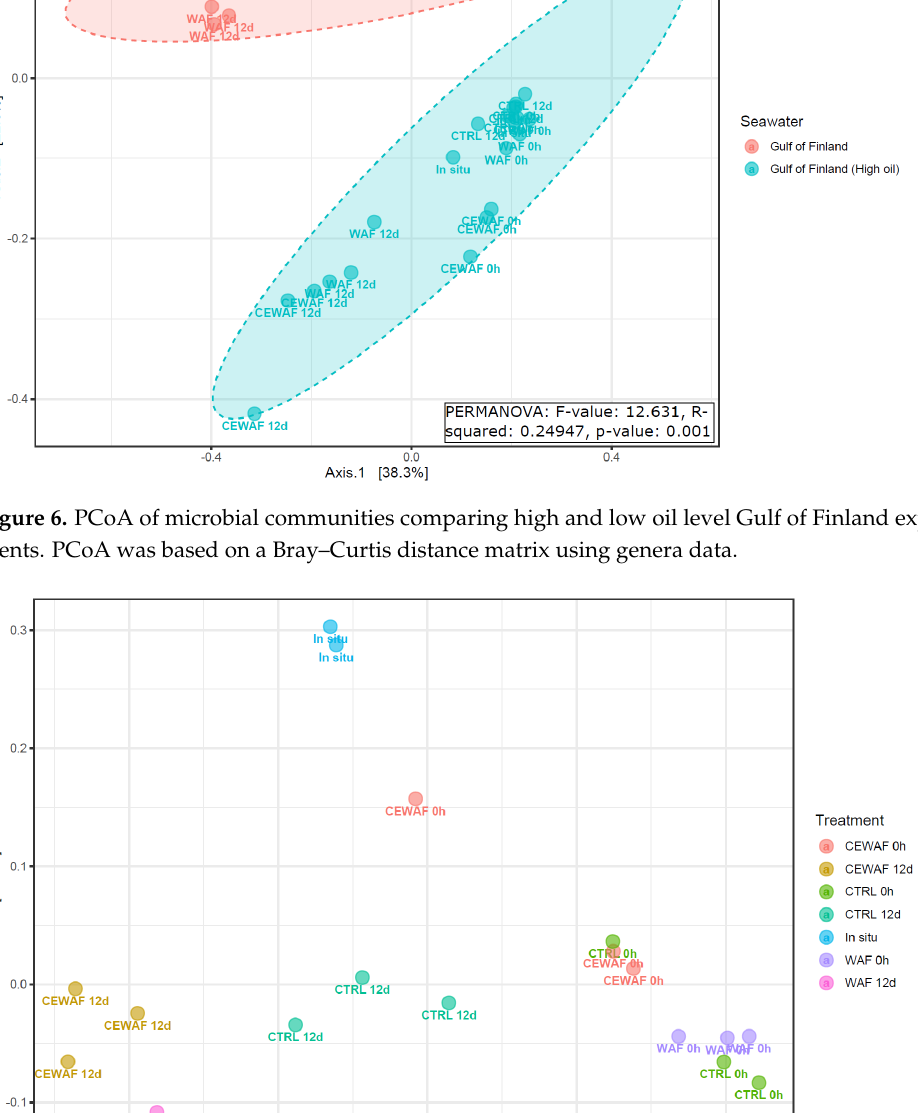
Figure 7. PCoA of microbial communities in the Norwegian Sea experiment. PCoA was based on a Bray–Curtis distance matrix using genera data.